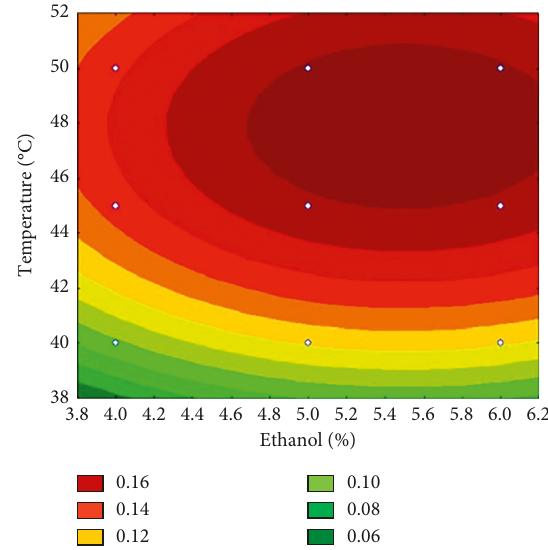
Figure 2: Response surface plot representing the effect of the var- 1 ) of beta-galactosidase extracted iables on enzymatic activity (UmL from Aspergillus oryzae CCT −